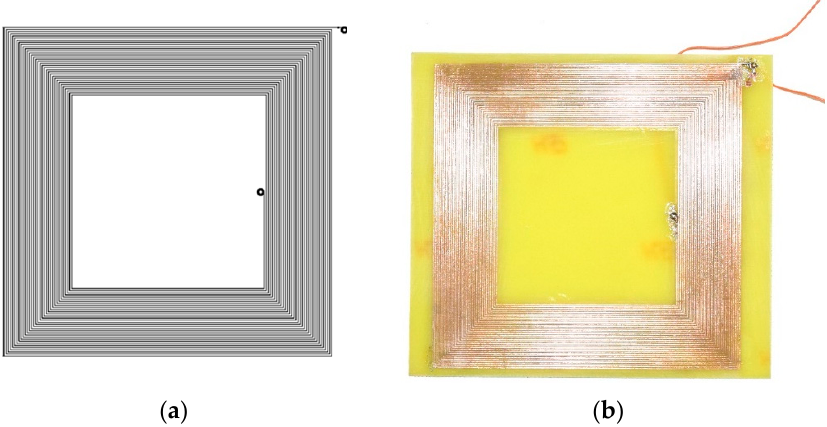
Figure 5. Printed coil produced for the experiment: ( a ) PCB layout designed using the WEBENCH